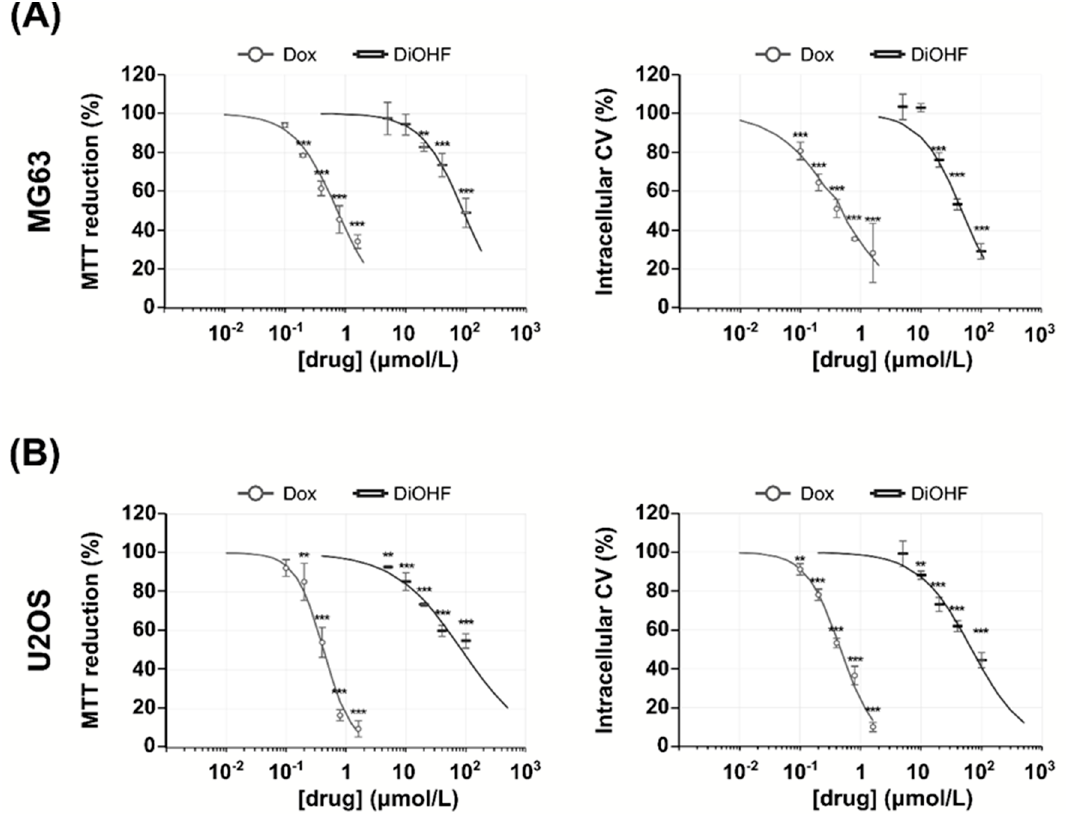
Figure 1. Cytotoxic effects of DiOHF. ( A ) MG ‐ 63 and ( B ) U2OS cells were incubated for 48 h with 5, 10, 20, 40 and 100 μ mol/L DiOHF or 0.1, 0.2, 0.4, 0.8 and 1.6 μ mol/L Dox. Cells were analyzed for cytotoxicity by MTT and CV assays. The data are mean ± SD ( n = 3). Significant differences (asterisks) are shown relative to 0.1% DMSO control; ** p < 0.01, *** p < 0.001 (one ‐ way ANOVA).